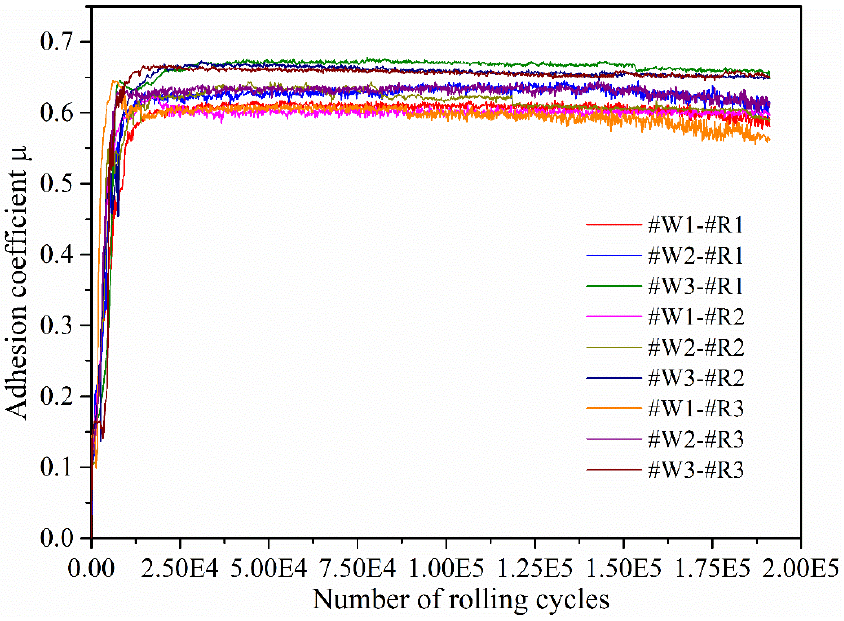
Figure 7. Variations of adhesion coefficients with the number of rolling cycles between different wheel / rail friction wheel/rail friction pairs.